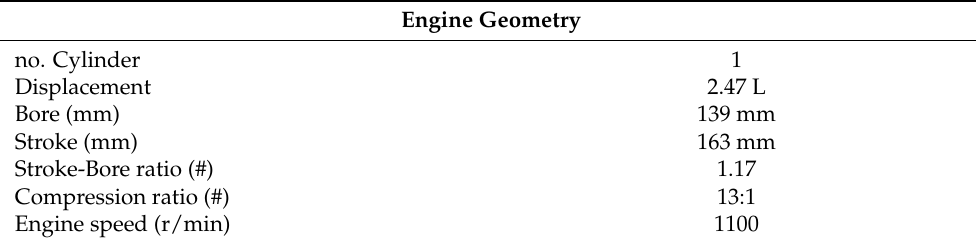
Table 1. Main specifications of the reference SI engine from